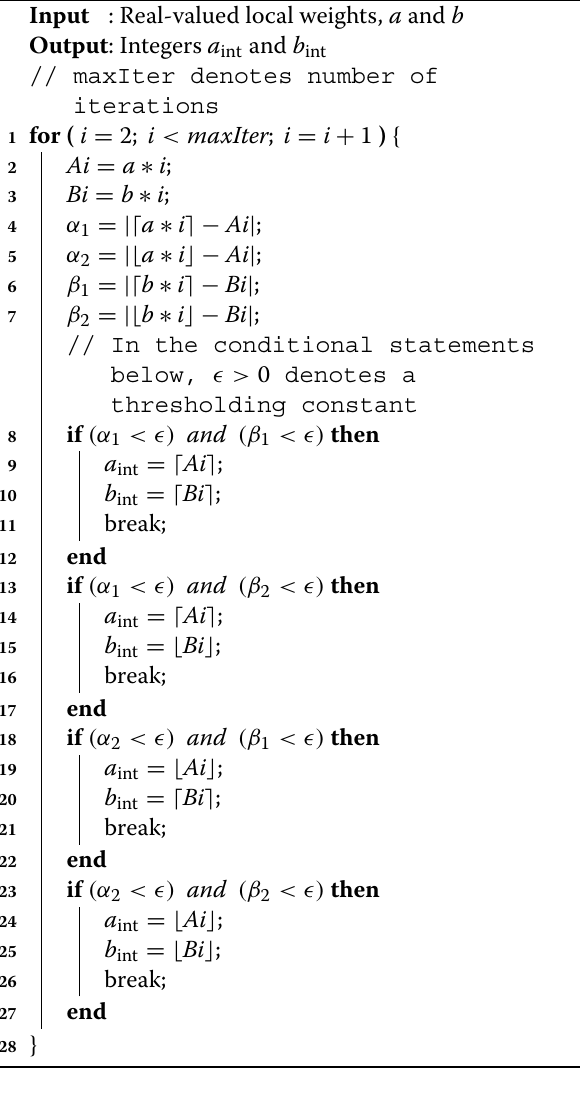
Algorithm 1: Computing integer-valued chamfer masks.